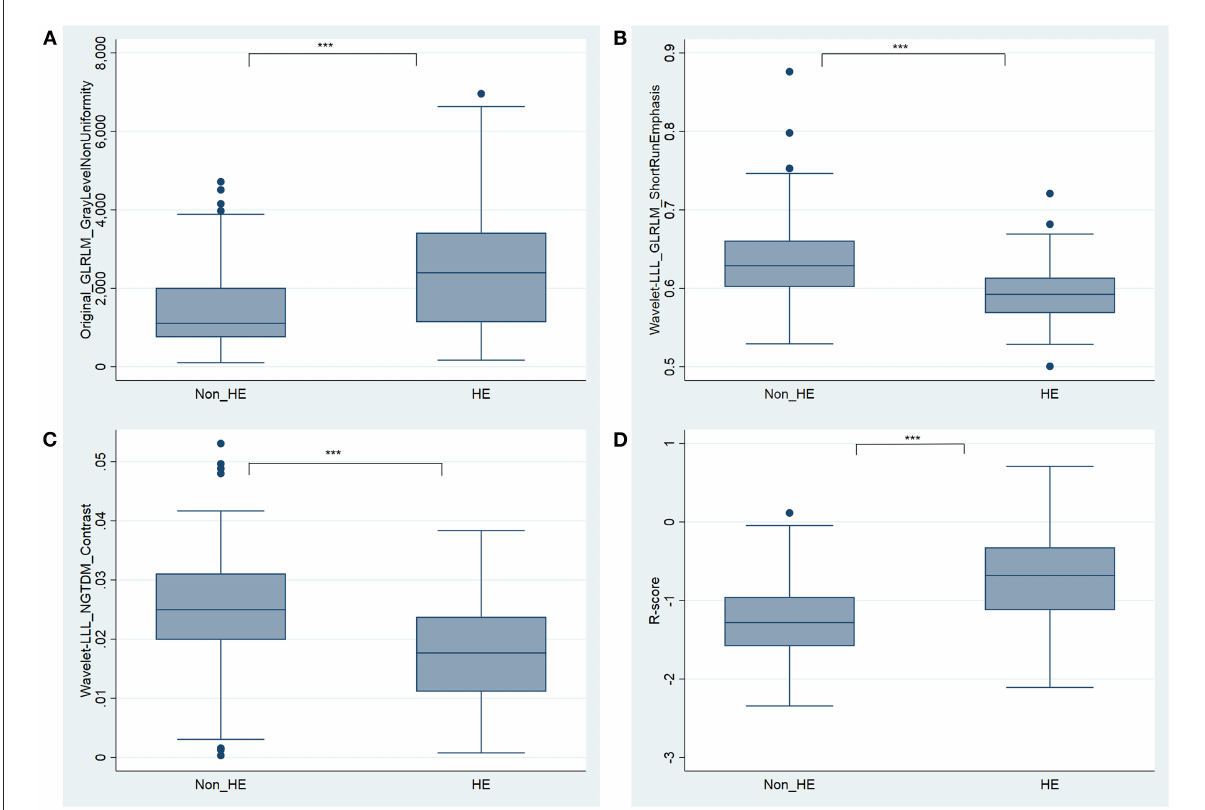
FIGURE3 Boxplots for the selected features [ (A) Original_GLRLM_GrayLevelNonUniformity, (B) Wavelet-LLL_GLRLM_ShortRunEmphasis, and (C) Wavelet-LLL_NGTDM_Contrast] and the constructed R-score (D) between HE and non-HE groups. *** significant at p < 0.001. HE, hematoma